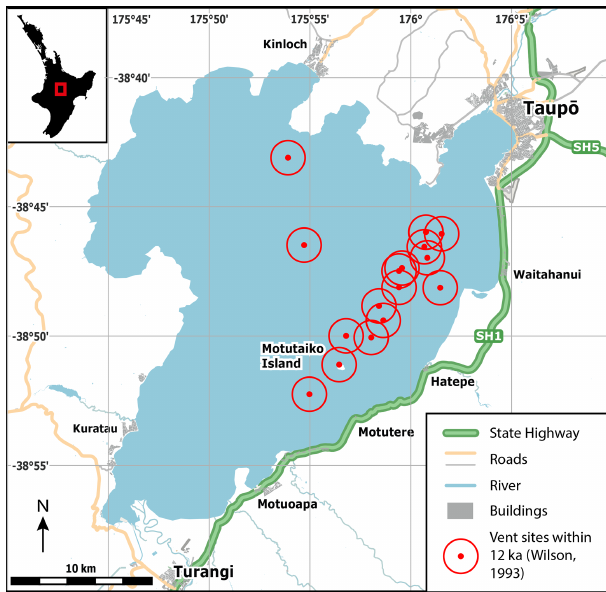
Figure 1. Setting of Lake Taup¯o with buildings and road infrastruc- ture, where major state highways are highlighted. Currently sub- merged vent site locations that have erupted within 12kyr from Wil- son (1993). Data sourced from OpenStreetMap. Map data © Open- StreetMap contributors 2022. Distributed under the Open Data Commons Open Database License (ODbL)